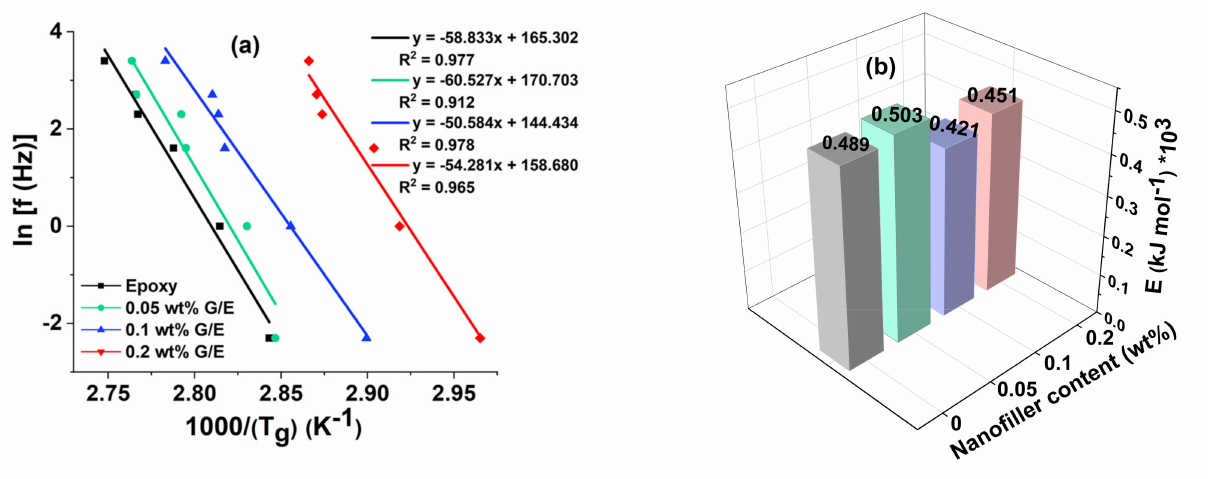
Figure 12. ( a ) Regression lines and ( b ) activation energy for all tested